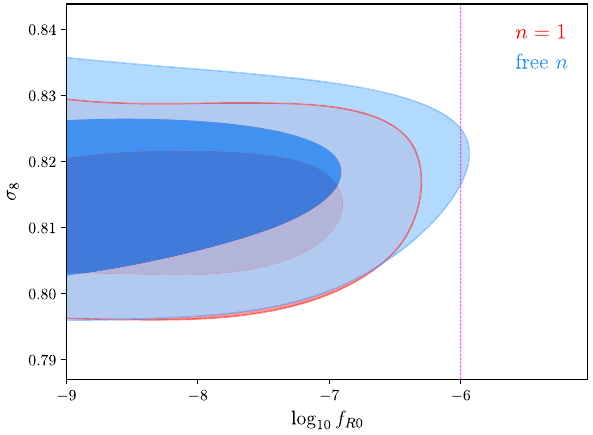
Fig. 3 The constrained 2-dimensional parameter spaces (log 10 f R 0 , σ 8 ) from the “C” dataset are shown for HS f (red), 2 (green), 3 (grey), 4 (orange) and free n (blue), respectively